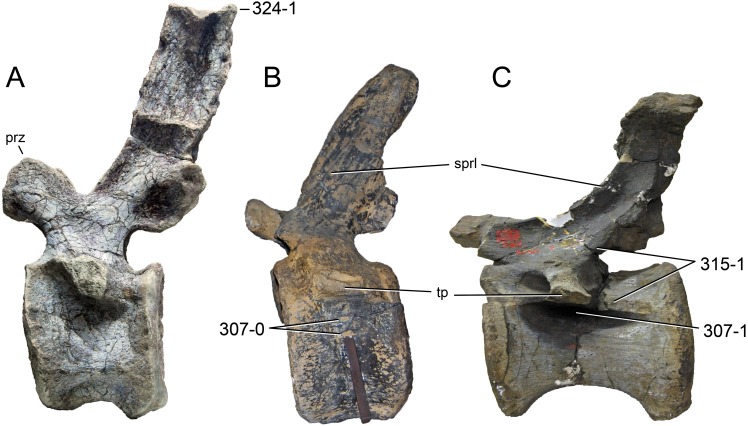
Flagellicaudatan anterior caudal vertebrae.Anterior caudal vertebrae of Dicraeosaurus hansemanni MB.R.3774 (A), the indeterminate apatosaurine NHMUK R.3211 (B), and Barosaurus lentus YPM 429 (C) in left lateral view. Note the reduced (B; C307-0) or large pneumatopores (C; C307-1), the distinct posterior centrodiapophyseal and postzygodiapophyseal laminae (C; C315-1), and the postspinal lamina that projects dorsally (A; C324-1). Abb.: prz, prezygapophysis; sprl, spinoprezygapophyseal lamina; tp, transverse process. Scaled to same posterior centrum height.